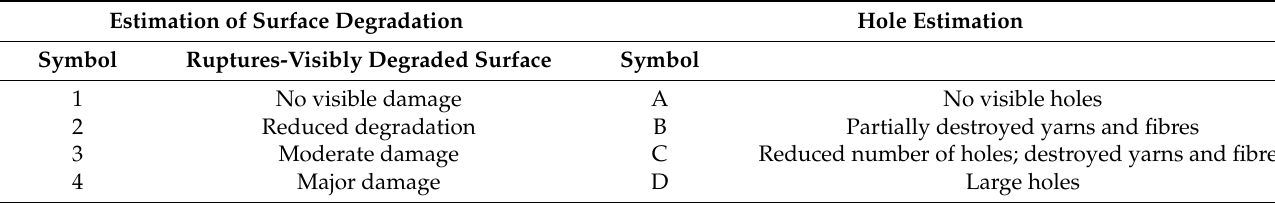
Table 3. Criteria for assessing insect